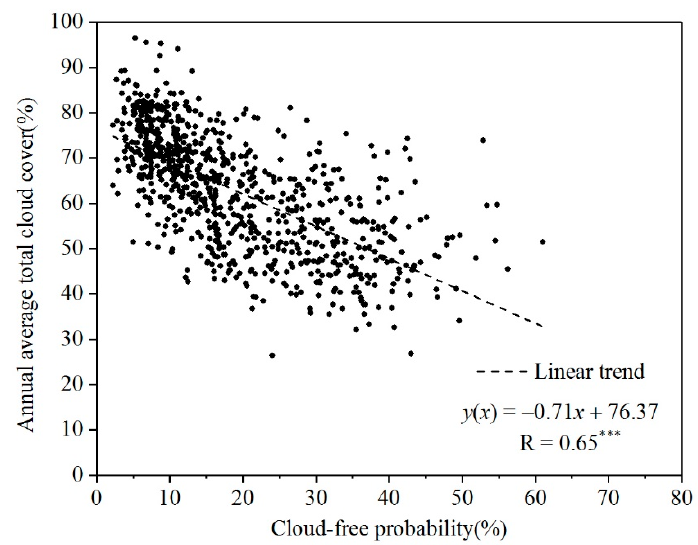
Figure 8. The relationship between the probability of acquiring cloud-free imagery with the annual average total cloud cover. *** means that R is significant when the significance level α was set to 0.01.